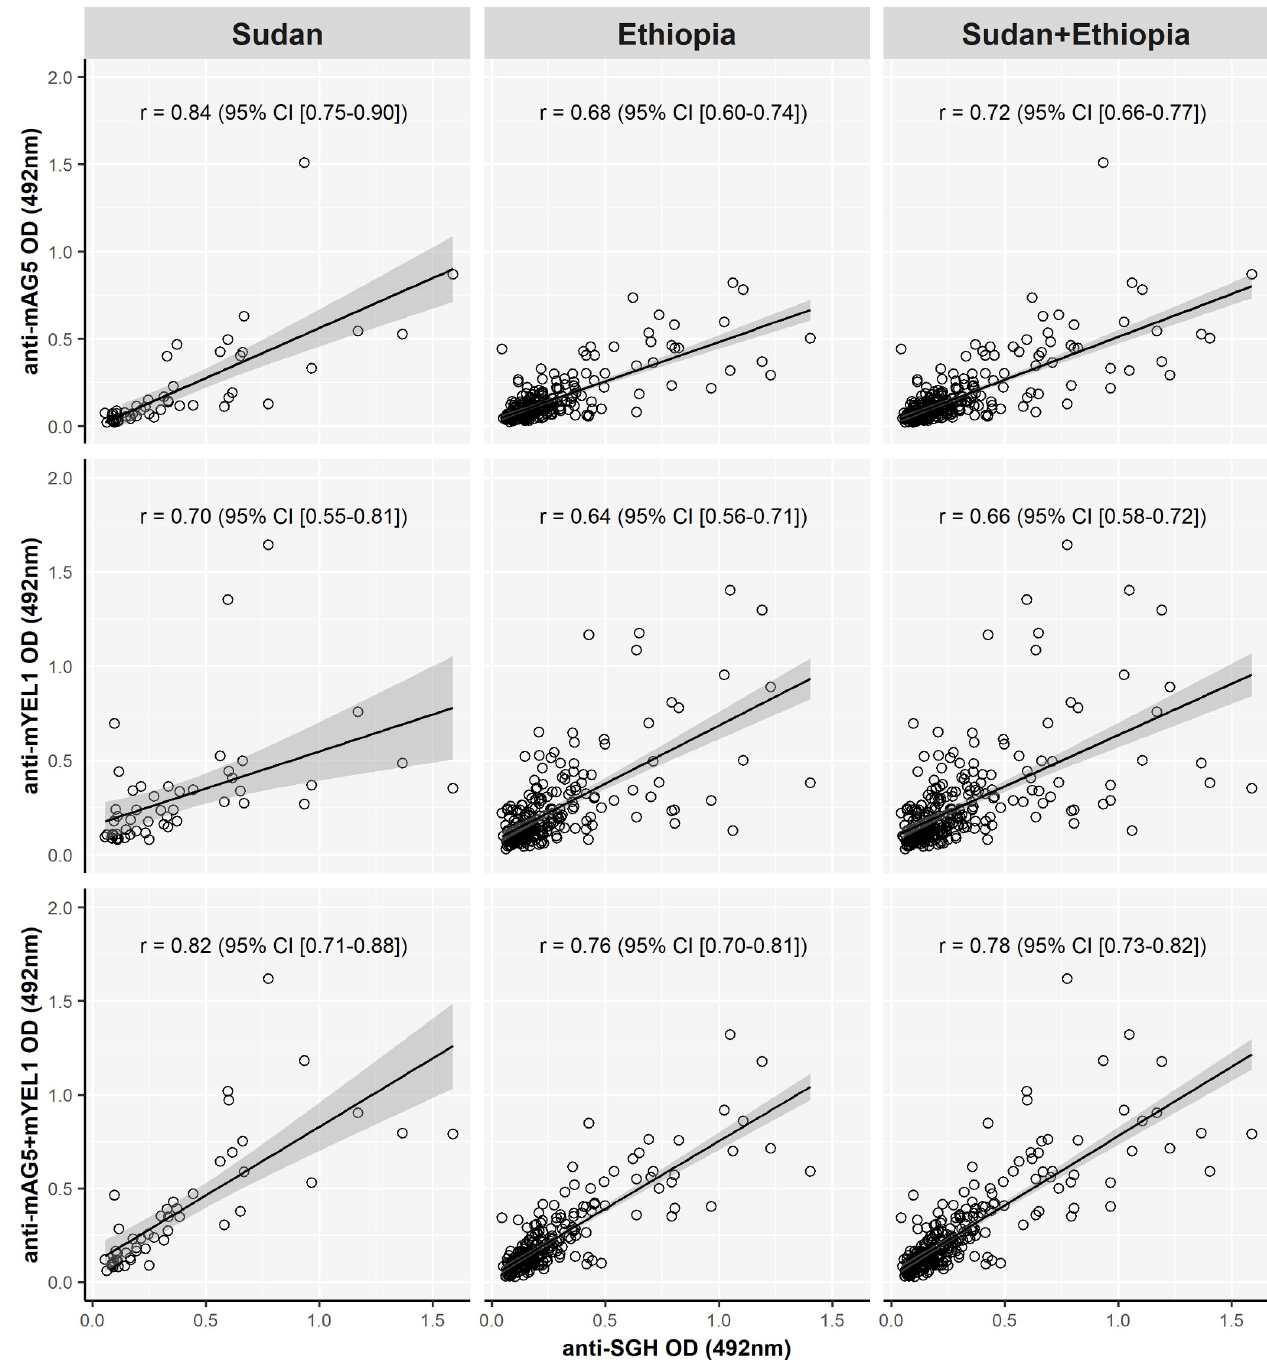
Fig 3. Correlations between IgG antibodies recognizing SGH and mAG5, mYEL1, or mAG5 + mYEL1 in human from Sudan and Ethiopia. Correlation between anti-SGH and anti-mAG5 (first row), between anti-SGH and anti-mYEL1 (second row) and between anti-SGH and combination of mAG5 and mYEL1 (third row) with Sudanese, Ethiopian, and serum samples from both localities together were performed by Spearman-Rank analysis. P value achieved in all analysis was below 0.0001. Correlation coefficients (r) and confidence intervals (CI) are indicated.